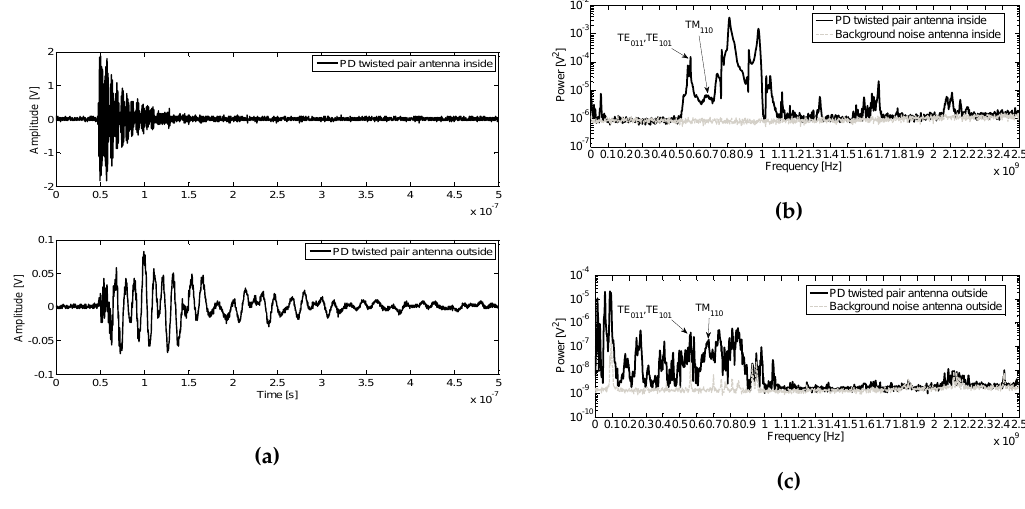
Figure 11. ( a ) Surface PD pulses in twisted pair at 760 V inside the enclosure acquired by the inner and outer antennas and their average power spectra compared with noise inside ( b ) and outside ( c ).